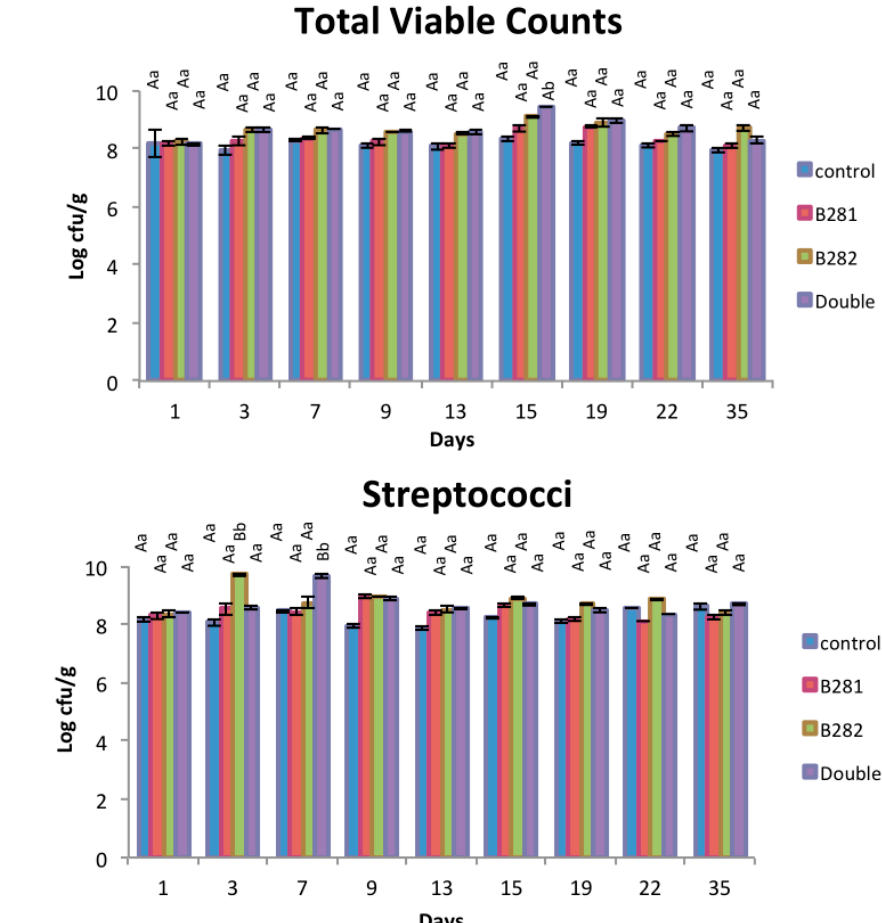
Figure 3. ( A ) Lactobacilli; ( B ) total viable counts; and ( C ) streptococci in yogurt samples during refrigerated storage. Means with different uppercase letters within the same treatment are significantly different ( p < 0.05). Means with different lowercase letters within the same storage day are significantly different ( p < 0.05).